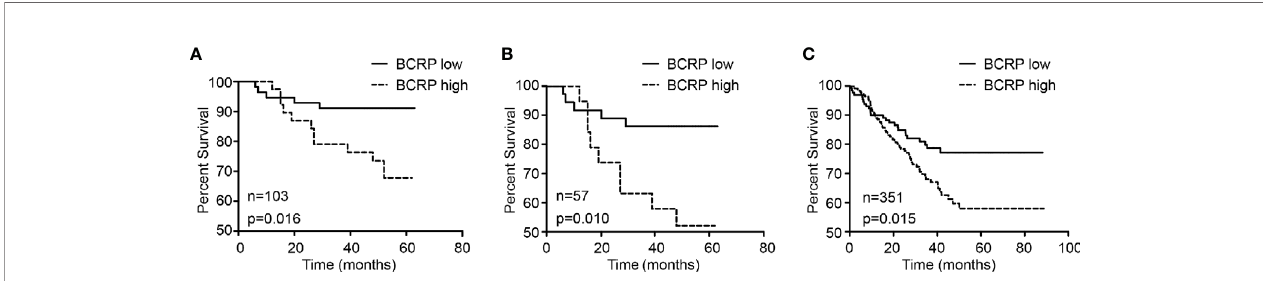
FIGURE 1 | BCRP was related to poor prognosis of BCa. (A) The correlation between BCRP expression in BCa tissue and overall survival (n = 103, p = 0.016, Kaplan-Meier survival analysis, log-rank test). (B) The correlation between BCRP expression in BCa tissue and overall survival among patients with lymph node